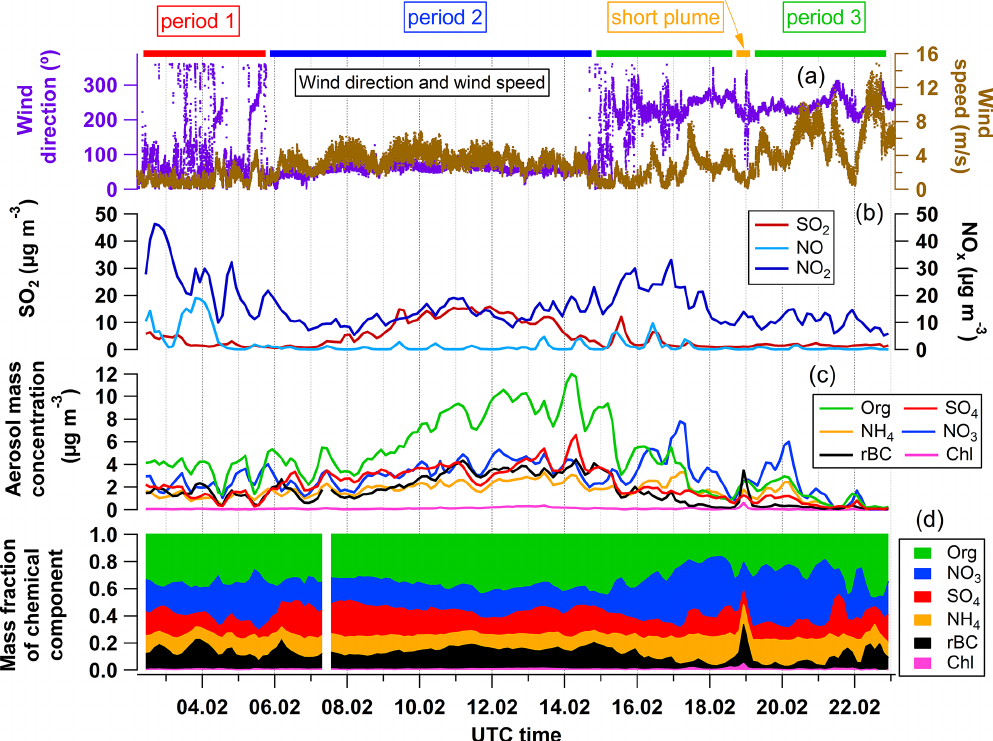
Figure 3. Time series of (a) wind direction and wind speed at 10min time resolution measured 6m above ground; (b) concentrations of gas-phase species SO 2 , NO, and NO 2 at 3h time resolution; (c) mass concentrations of aerosol-phase chemical components measured by the ACSM and the SP2 at 3h time resolution; and (d) relative mass fractions of the measured aerosol chemical